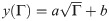
Refined data analysis for local marriages in Spain.Panel a: log-log scale plot of LMαi,y versus Γαi,y, where different regions are denoted in different colours and symbols, as explained in the legend. These data are properly binned (green squares) and best-fitted (solid line) by y(Γ)=aΓ+b, in agreement with the theoretical result (2). The best-fit coefficients are a = 1.852 and b = −5.16 ⋅ 10−4. Notice that the parameter b accounts for the standard deviation associated to binned data. It is clear, even by visual inspection, that a few regions slightly deviate from the best-fit curve. In the insets we show, as examples, the data pertaining to two selected regions, namely Castilla La Mancha (upper inset) and Galicia (lower inset). Notice that for both the best-fit previously obtained for the whole data set (solid line) still provides a proper fit. Panel b: For each region we calculate ρ
α, as defined in the text and deepened in the Theoretical Protocol Section. The horizontal line is drawn as a reference for the unitary value. Notice that the largest deviation from the unitary value is for Melila. From this plot we can distinguish regions displaying a relatively large number of marriages (i.e., ρ
α > 1) and regions displaying a relatively small number of marriages (i.e., ρ
α < 1). This division is highlighted in the colormap presented in panel c. Interestingly, regions exhibiting analogous deviations share a certain degree of geographical proximity: regions with ρ
α > 1 (dark shading) correspond to the Southern part of Spain and to Basque region (with some adjacent regions), while regions with ρ
α < 1 (bright shading) correspond to the North-Western part of Spain. Panel d: the two clusters of regions highlighted are analyzed separately. For each we bin the related raw data and get a best fit, still according to the function y(Γ)=aΓ+b, obtaining a
up = 1.95 and b
up = −1.79 ⋅ 10−4 (R
2 = 0.97) for the set of regions with ρ
α > 1, and a
down = 1.84 and b
down = −8.37 ⋅ 10−4 (R
2 = 0.99) for the set of regions with ρ
α < 1; notice that a
up/a
down ≈ 1.1. Binned data for the former set (triangles) and for the latter set (square) are shown in the main panel, together with the related best fits, in a log-log scale plot. These fits are not significantly better that the one obtained at the country level, suggesting that possible internal heterogeneities may be rather limited. In the insets we compare these best fits with raw data for two regions (Andalucia and Comunitat Valenciana) with ρ
α > 1 (upper inset) and two regions (Castilla y Leon and Cataluna) with ρ
α < 1 (lower inset). Notice that in both cases data points overlap both curves, again suggesting that the division highlighted here is rather mild.